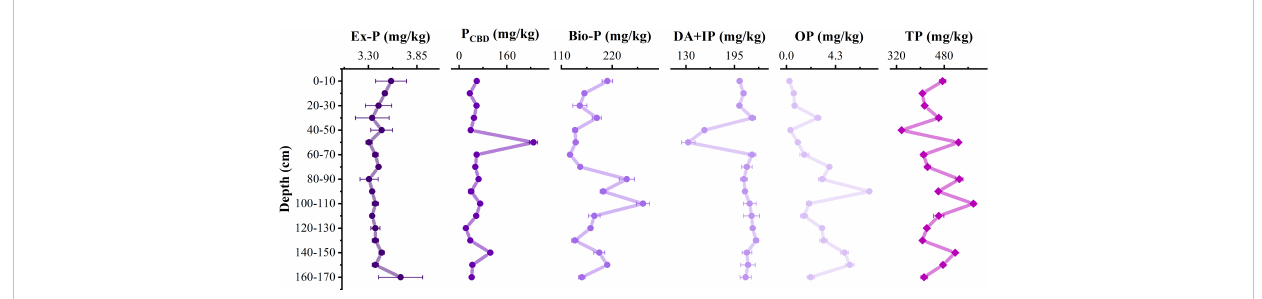
FIGURE 5 Distribution of different forms of phosphorus at vertical pro fi le. Ex-P represents exchangeable or loosely sorbed phosphorus, P CDB represents iron- bound phosphorus, Bio-P represents authigenic apatite, CaCO 3 -bound P and biogenic apatite, DA+IP represents detrital apatite plus other inorganic phosphorus, OP represents organic phosphorus, and TP represents total